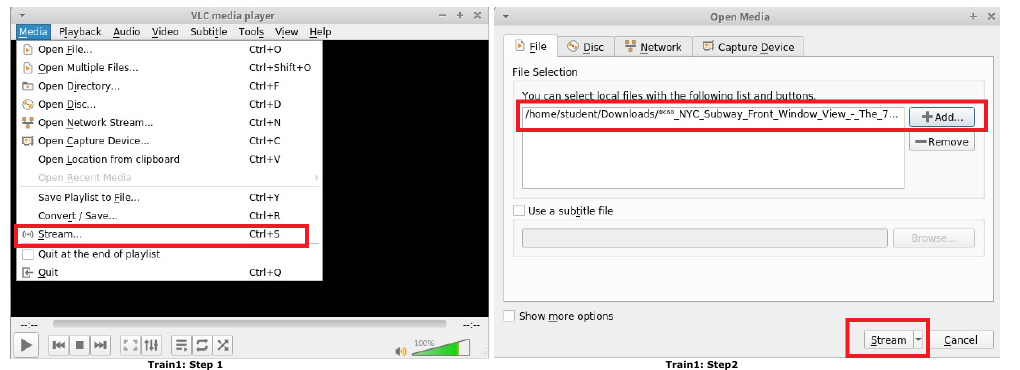
Figure 32. VLC player execution At Train1 and RailServer.